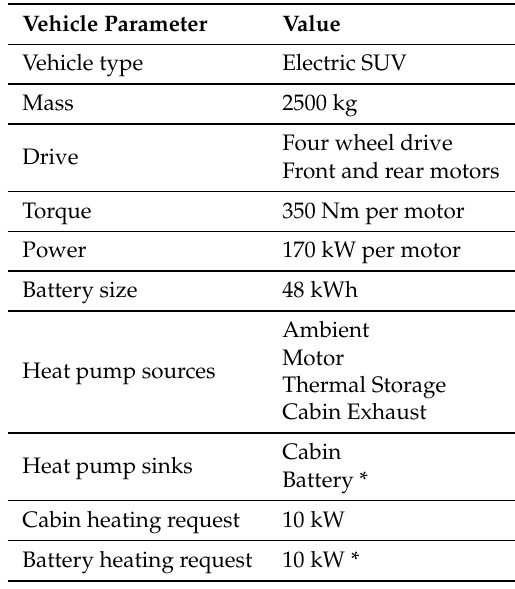
Figure 1. Schematic depiction of heat pump architecture with interactions highlighted. X(1), X(2), and U refer to the state variables and control vector of the optimisation described in Section 5. Table 1. Parameters relating to the vehicle model used for this research. * The thermal connection is to be dynamically controlled as a result of the